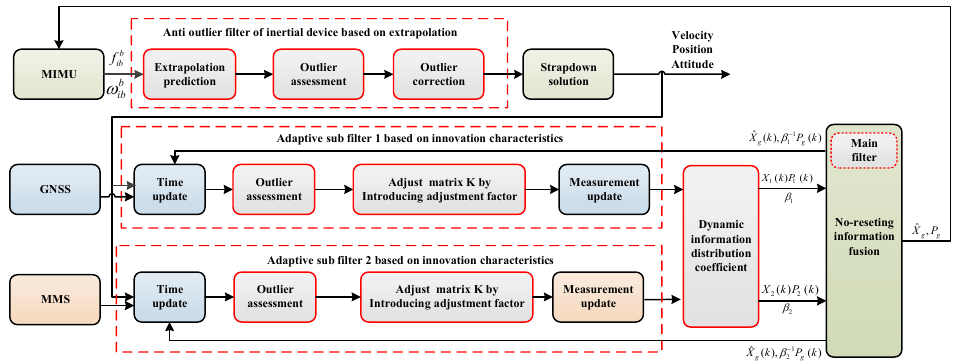
Figure 2. The overall flow of the improved innovation robust outliers detection method.